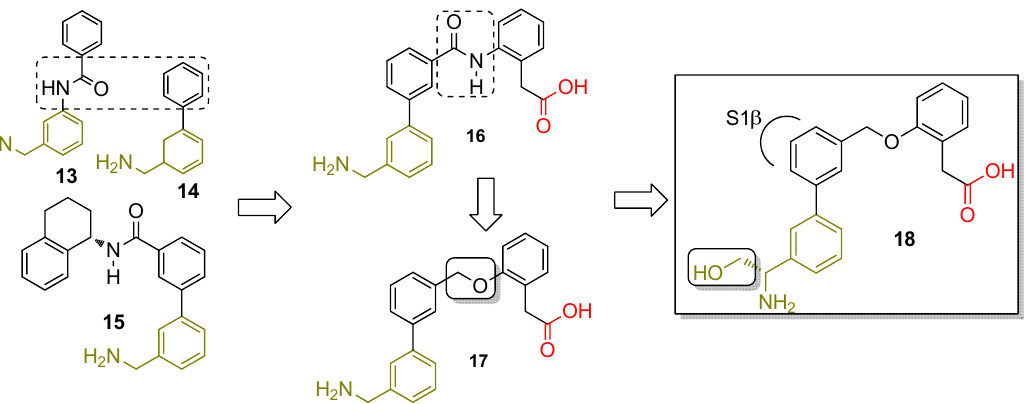
Figure 9. Structure-based drug design led to the discovery of potent and selective FD inhibitor 18 targeting the “unlocked” FD conformation. 18 had IC 50 values of 12 nM and 260 nM in the thioesterolysis and human 50% whole blood MAC assays, respectively, accompanied by 83% oral bioavailability in mice.